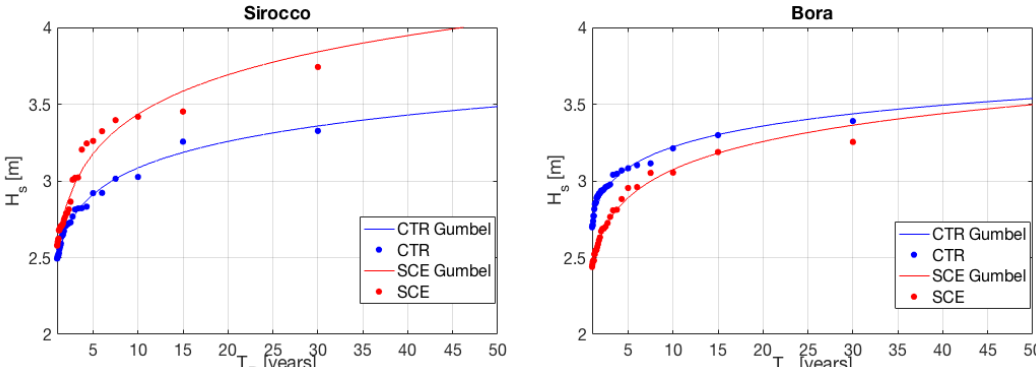
Figure 4. Statistics of extreme events for CTR (blue) and SCE (red) runs for Sirocco ( left panel ) and Bora ( right panel ) events. Filled dots show extreme values from simulations; tendency curves following Gumbel distribution are plotted in solid lines.